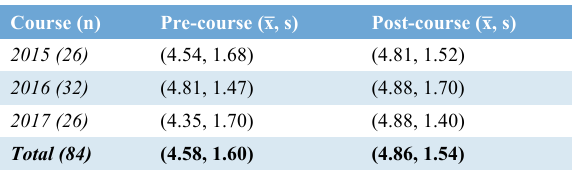
Tab. 3. Propensity to act: Year-by-year results for the question How likely is it that you will pursue a career as